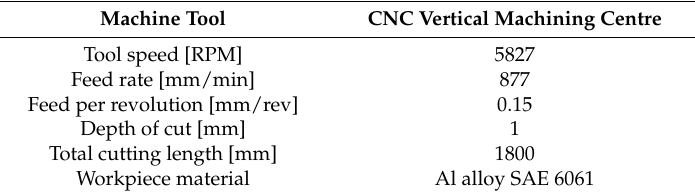
Table 1. Cutting